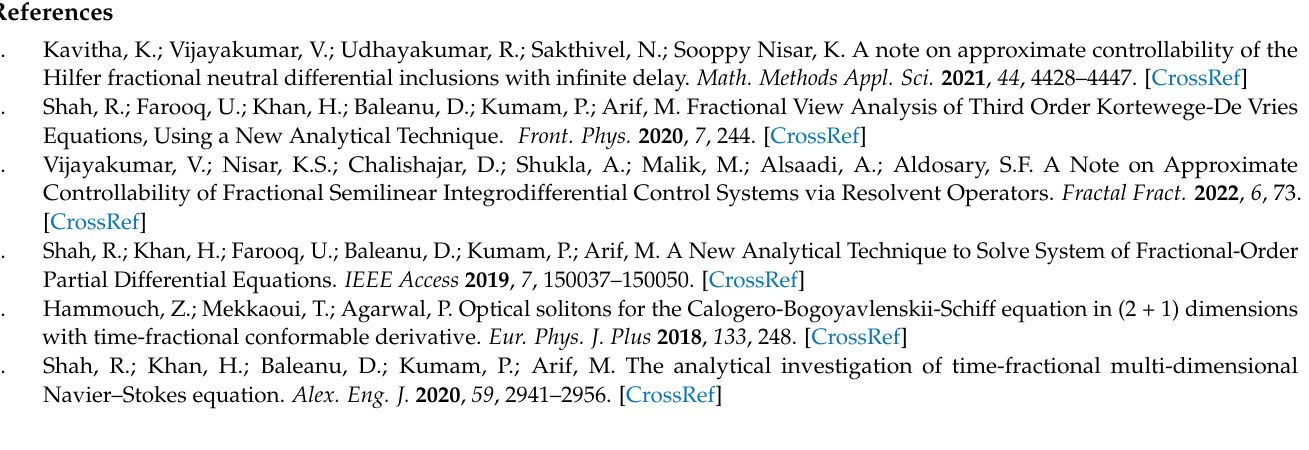
V ( ε , (cid:61) ) at ℘ = 0.75